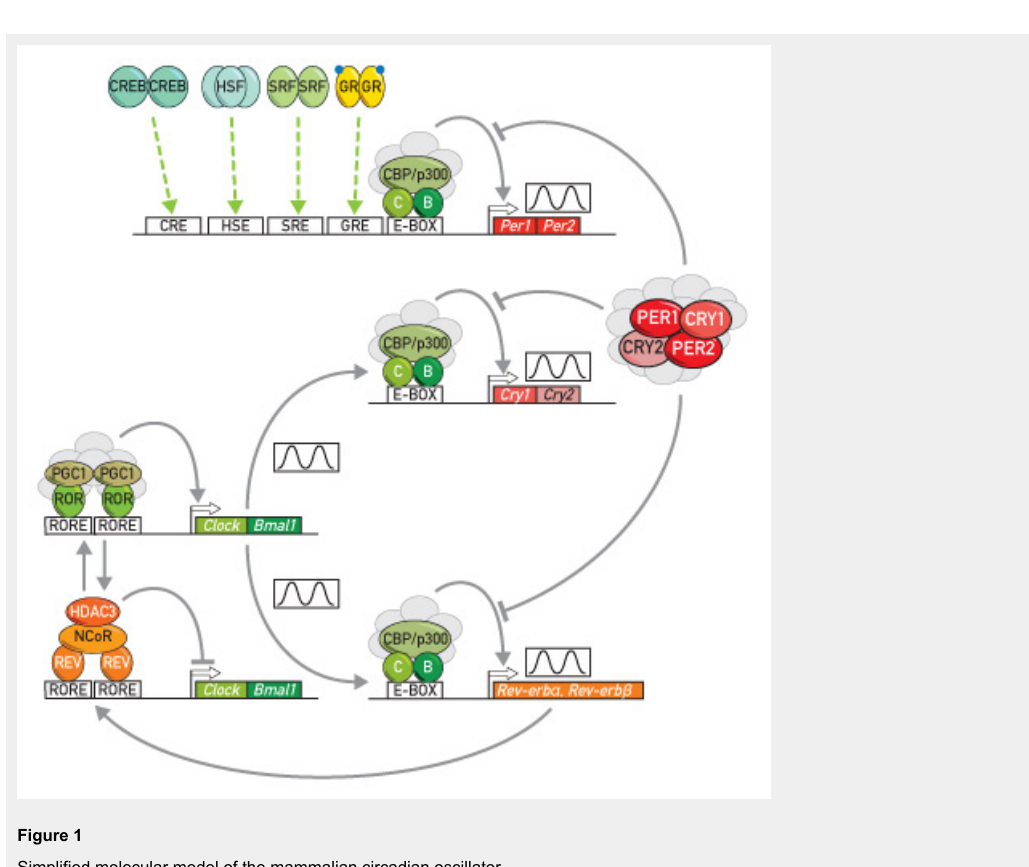
Simplified molecular model of the mammalian circadian oscillator. The two transcription factors CLOCK (C) (or its closely related paralog NPAS2) and BMAL1 (B) lie at the centre of the two coupled feedback loops in clock gene expression. CLOCK and BMAL1 recruit the coactivator proteins CBP/p300 and a few other polypeptides (shown in grey) and thereby activate the transcription of their target genes in the first feedback loop ( Per1 , Per2 , Cry1 , Cry2 ) and in the second (accessory) feedback loop ( Rev-erbα , Rev-erbβ ). Together with a large number of additional polypeptides (shown in grey) PER1, PER2, CRY1, and CRY2 assemble into large protein complexes. Once these repressor complexes have reached a threshold concentration and/or activity, they annul the transactivation activity of CLOCK and BMAL1. Under these conditions, the messenger PER and CRY mRNAs and proteins are no longer made, and the repressor complexes diminish until they no longer inhibit the activity of CLOCK and BMAL1. As a consequence, a new 24-hour PER and CRY production cycle can ensue. In a second feedback loop CLOCK and BMAL1 activate and PER/CRY complexes repress the transcription of the genes encoding the two repressors REV-ERBα and REV-ERVβ (REV). The circadian expression of REVs results in the rhythmic repression of the Clock and Bmal1 genes. When REV concentrations are low, ROR transcription factors bind to RORE elements within promoter and enhancer regions of these two genes and activate transcription by recruiting protein complexes containing the coactivator PGC1. When REV concentrations are high, REV competes with RORs for the binding to RORE elements and recruits protein complexes containing the corepressor NCoR and the histone deacetylase HDAC3. Per1 and Per2 genes not only serve as core clock components, but also as immediate early genes. Their expression can be stimulated by immediate early transcription factors whose activity is controlled by systemic cues, such as hormones, second messengers, temperature, and neurotransmitters. These immediate early transcription factors include cyclic AMP responsive element (CRE) binding protein (CREB), heat shock transcription factor 1 (HSF) binding to heat shock elements (HSE), serum response factor (SRF) binding to serum response elements (SRE), and glucocorticoid receptor (GR) binding to glucocorticoid responsive elements (GRE). The modulation of Per1 and Per2 expression by these signal sensing transcription factors plays an important role in the synchronisation of circadian clocks. Arrows and bars at the end of connecting lines indicate activation and repression, respectively of